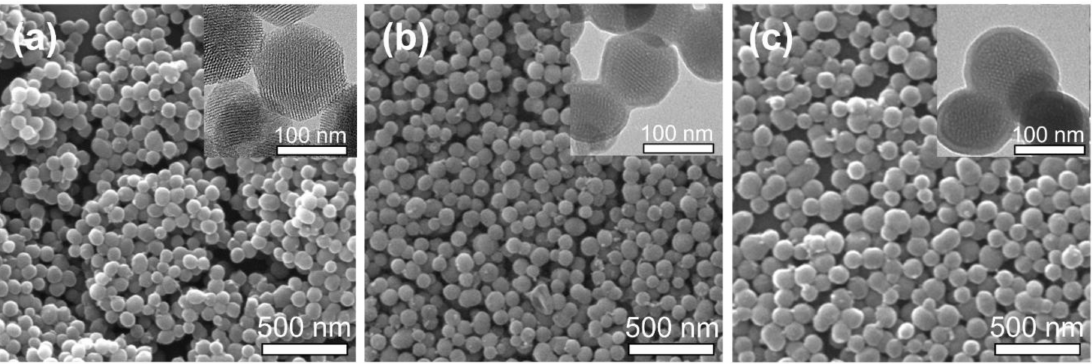
Figure 1. Morphological characterization of MSNs, MSNs@lip-1 and MSNs@lip-2: ( a ) SEM and TEM images of MSNs; ( b ) SEM and TEM images of MSNs@lip-1; ( c ) SEM and TEM images of